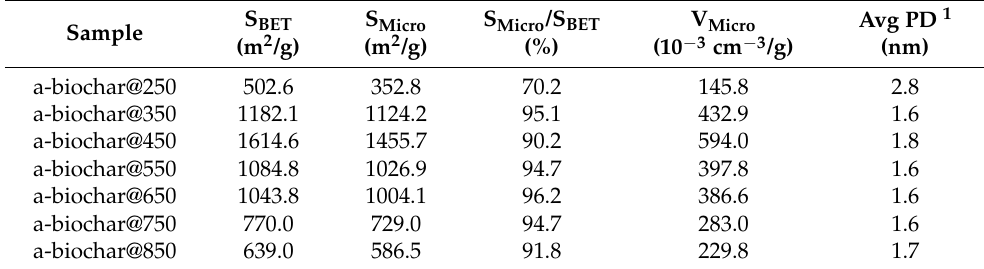
Table 2. Nitrogen adsorption isotherm parameters of activated biochars.